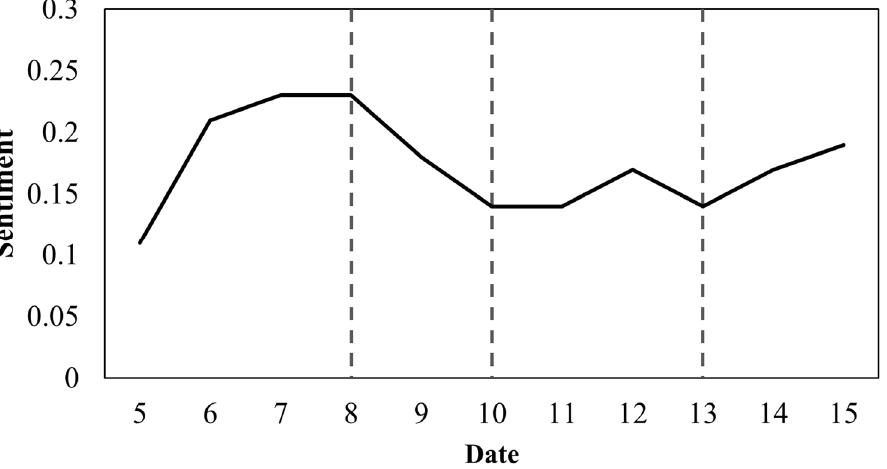
Figure 3. Time series of the daily mean value of public sentiment during Typhoon Haiyan from 5 November 2013 to 15 November 2013.